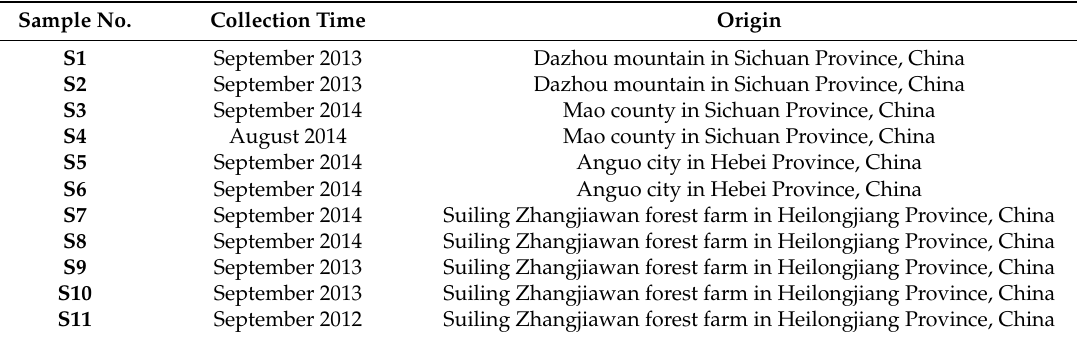
Table 11. The CRM samples with their different harvest times and habitats. Sample